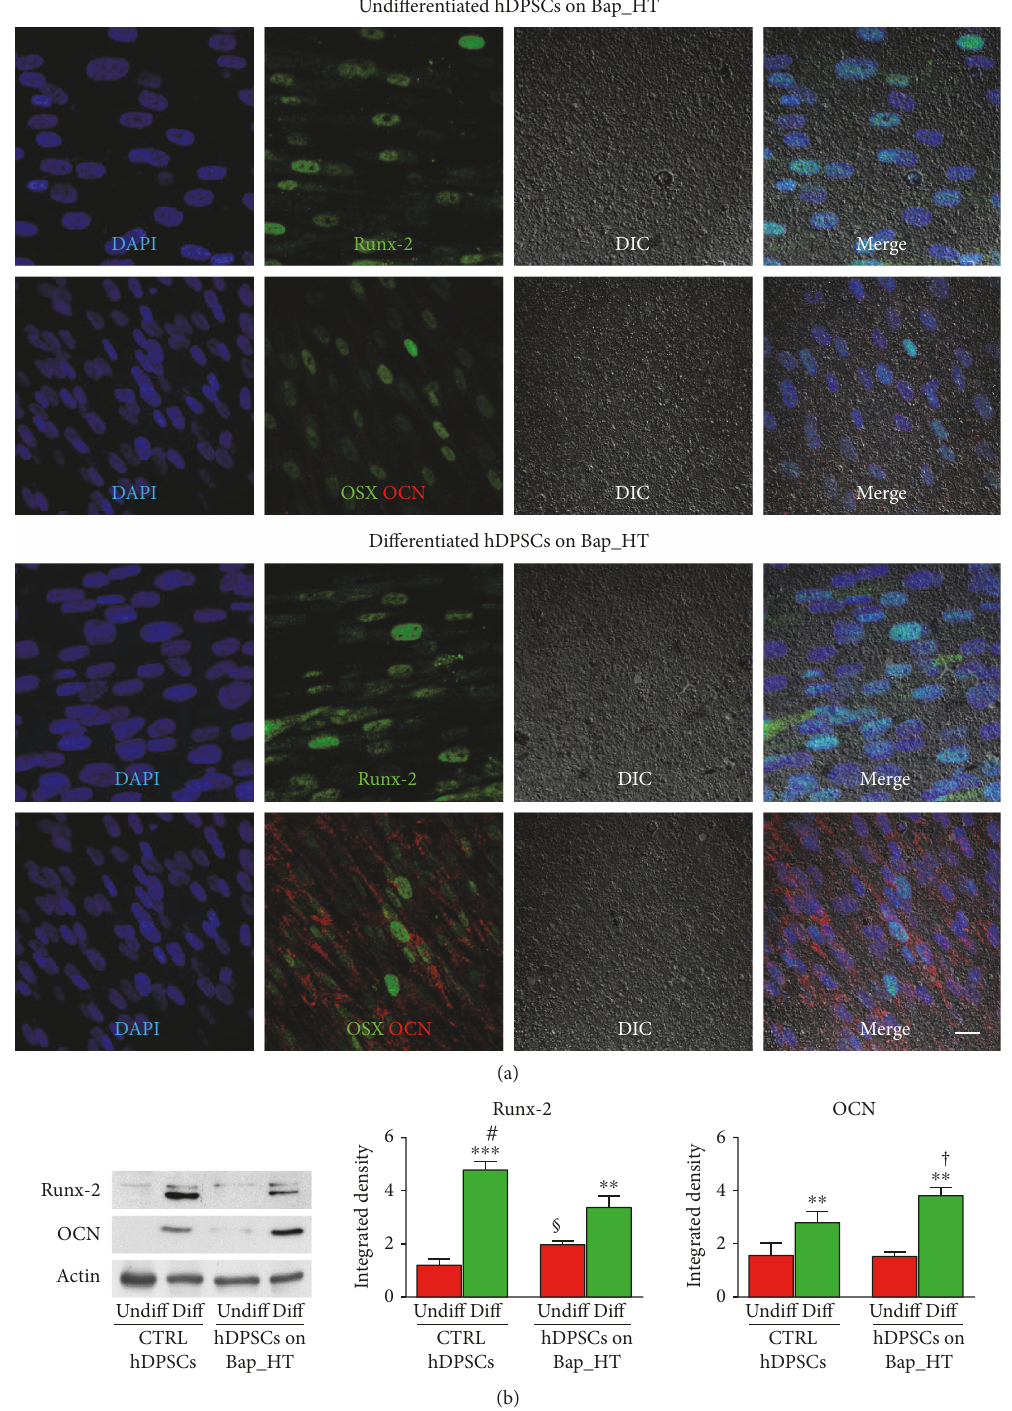
Figure 5: (a) Immuno fl uorescence analysis performed on undi ff erentiated hDPSCs and on osteogenic di ff erentiated hDPSCs cultured on BAp_HT fi lms for 3 weeks in standard culture conditions and osteogenic medium, respectively. Representative images show the expression and cellular localization of Runx-2, OSX, and OCN. DIC images report fi lm adhesion at 3 weeks of culture and hDPSC distribution on the fi lm surface. Nuclei were counterstained with DAPI. Scale bar: 10 μ m. (b) Western blot analysis was performed on undi ff erentiated and osteogenic di ff erentiated hDPSCs grown on control glass coverslips and on BAp_HT fi lms, respectively, for Runx-2 and OCN expression. Histograms represent densitometry analysis of Runx-2 and OCN. Actin bands were used as loading control. ∗∗ P < 0 01 , ∗∗∗ P < 0 001 di ff erentiated hDPSCs versus undi ff erentiated hDPSCs grown on the two di ff erent surfaces; # P < 0 05 di ff erentiated hDPSCs on control coverslips versus di ff erentiated hDPSCs on BAp_HT fi lm; § P < 0 05 undi ff erentiated hDPSCs on BAp_HT fi lms versus undi ff erentiated hDPSCs on control coverslips; † P < 0 05 di ff erentiated hDPSCs on BAp_HT fi lms versus di ff erentiated hDPSCs on control